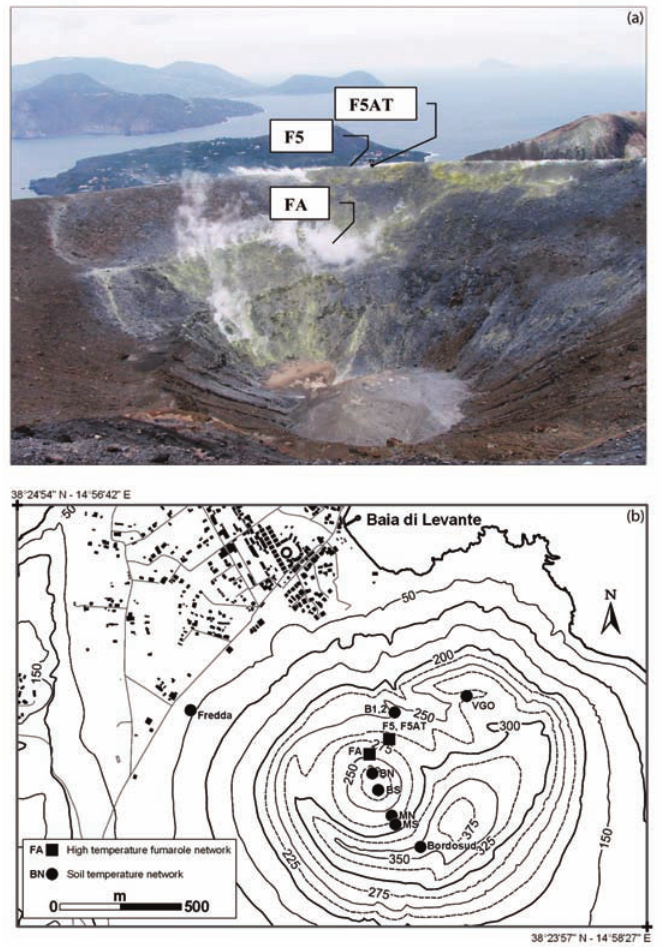
Figure 2. (a) Photograph of the fumarolic field of the La Fossa cone, taken from the southern side of the outer edge. The location of the F5AT, F5 and FA monitoring points are indicated. (b) Mapped locations of the temperature monitoring sites (with 1-h sampling rates) installed at the La Fossa cone by the Istituto Nazionale di Geofisica e Vulcanologia, sezione di